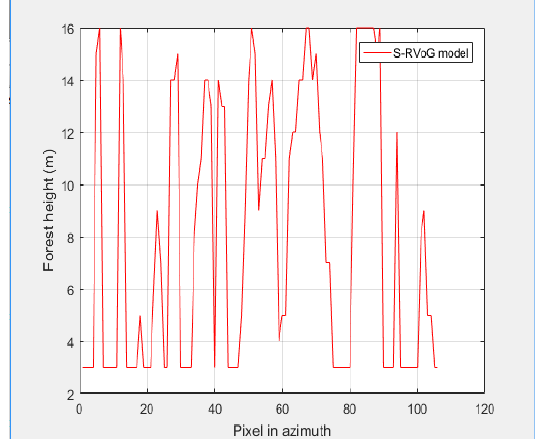
Figure 7. Height estimation result of Three-Stage inversion method using S-RVoG model